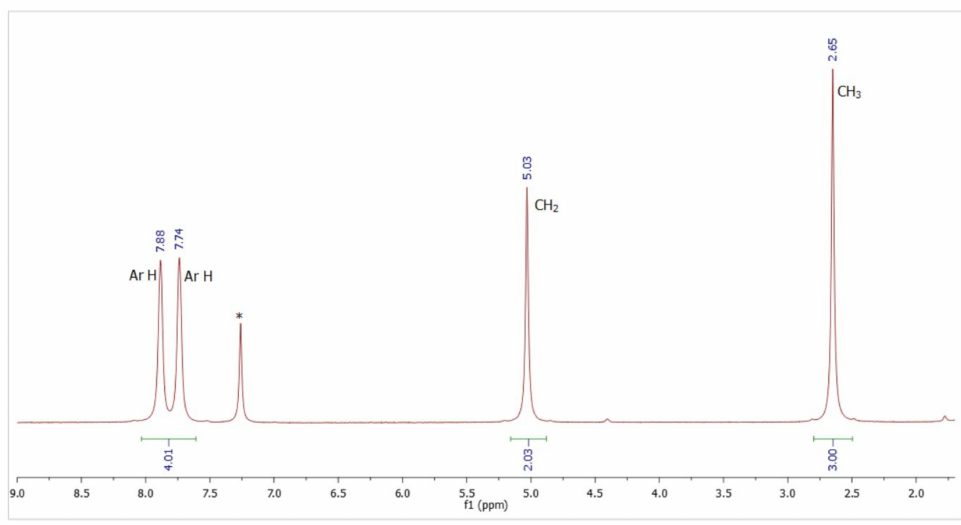
Figure 2. 1 H-NMR spectrum (400 MHz, CDCl 3 ) of compound 2 at 25 ◦ C. The asterisk * denotes the chloroform